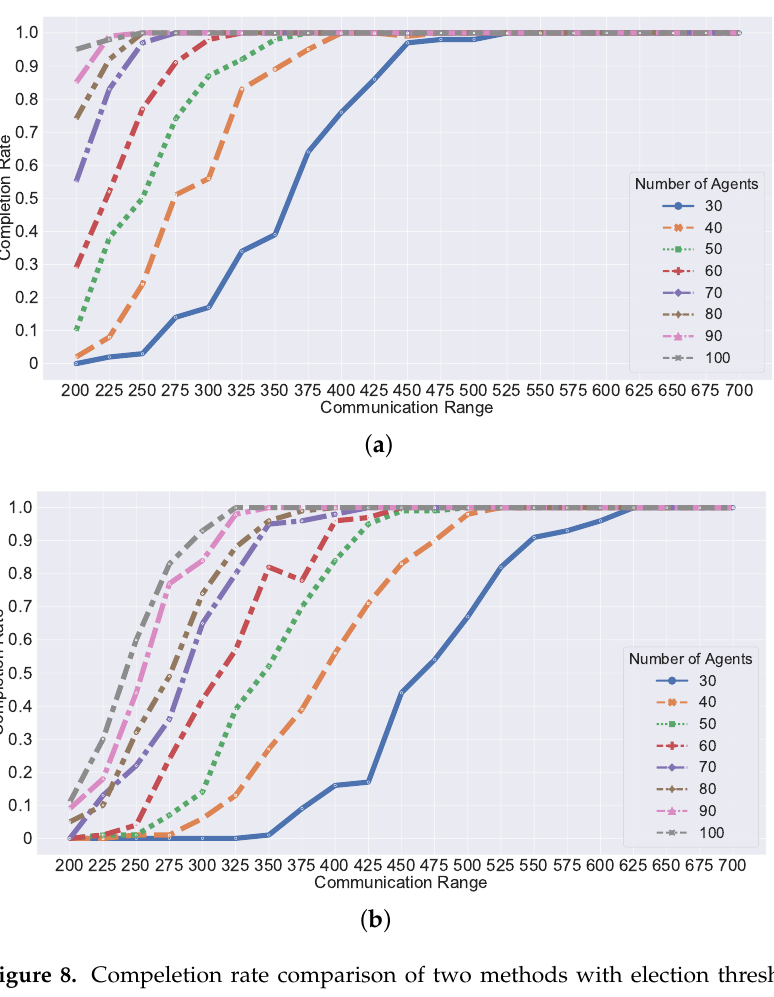
Figure 8. Compeletion rate comparison of two methods with election threshold of 15. ( a ) Our proposed method with respect to different swarm size. ( b ) The Raft-based method with respect to different swarm size.